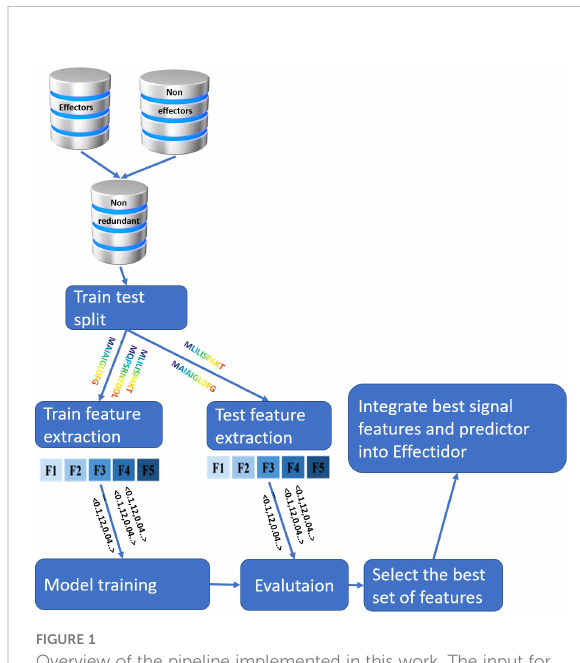
FIGURE 1 Overview of the pipeline implemented in this work. The input for the feature extraction are the N-terminal protein sequences, {F1,..., F5} represent different features, and the input to the model training and evaluation are the vectorial representations of the protein samples, as represented by the